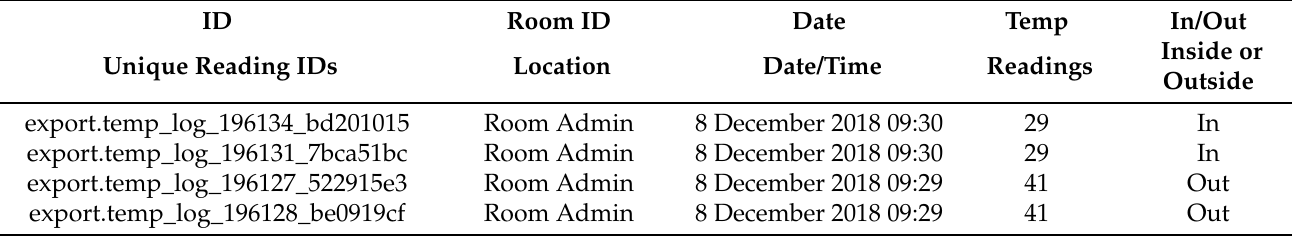
Table 1. IoT temperature sample data [48]. Temperature readings on enterprise building room, both inside and outside, recorded at random intervals (one sample per second).